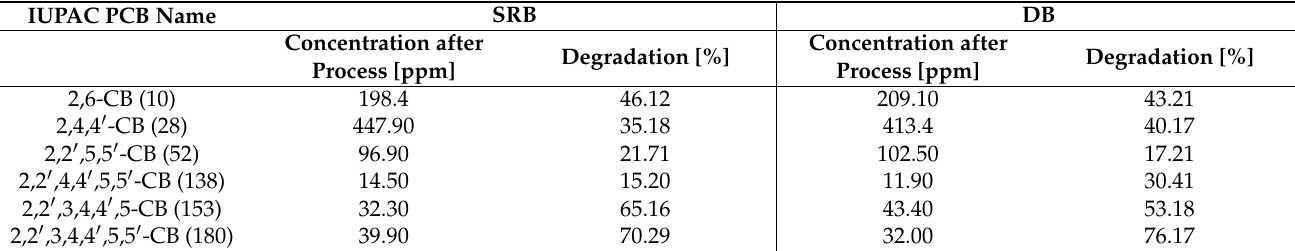
Table 3. The degradation of chosen PCB